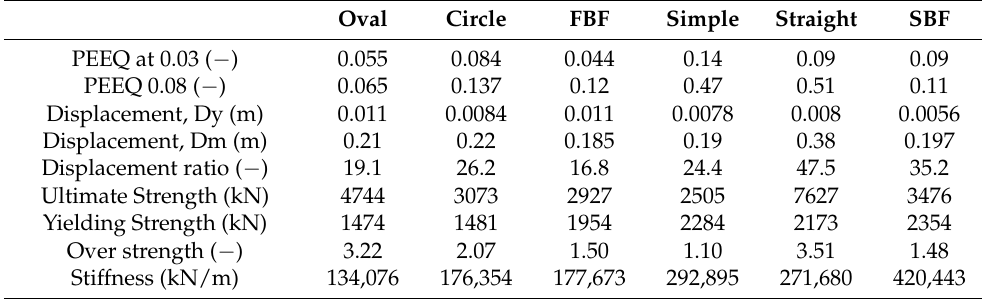
Table 4. The computational results for MRLs.